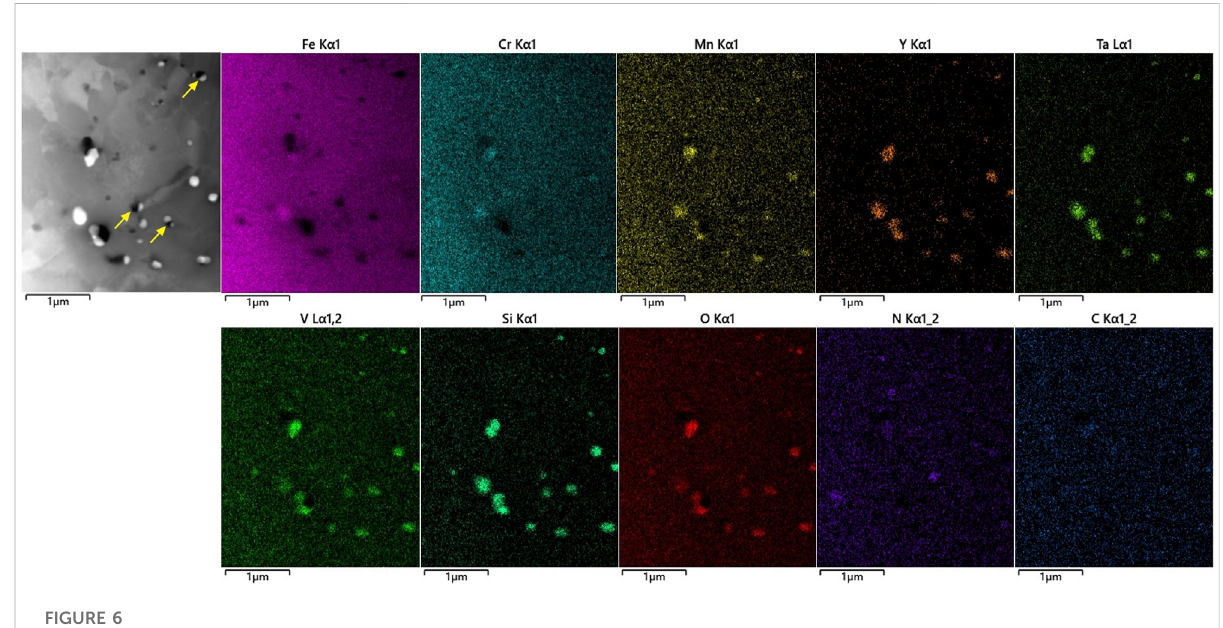
FIGURE 6 STEM image and elemental mappings of two types of large precipitates.